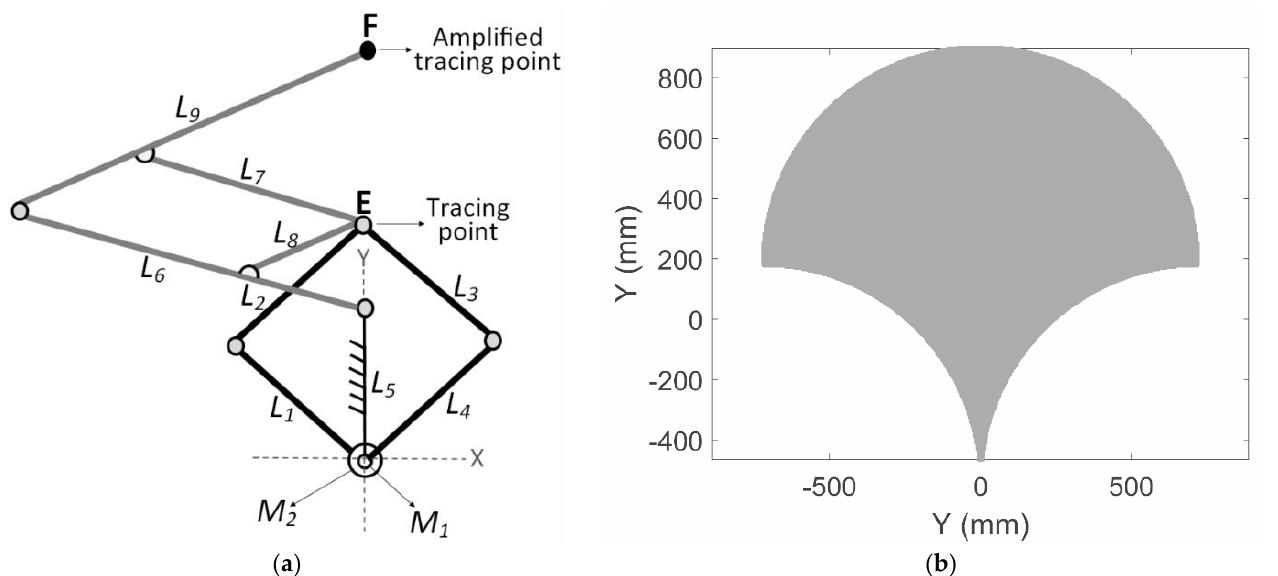
Figure 1. Nurse device: ( a ) scheme of the linkage structure; ( b ) mechanism